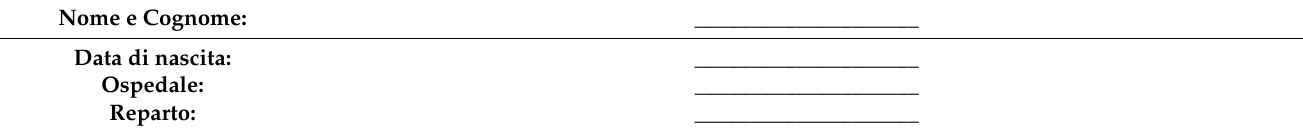
Table 1. Wessex Head Injury Matrix (62 Items), Italian